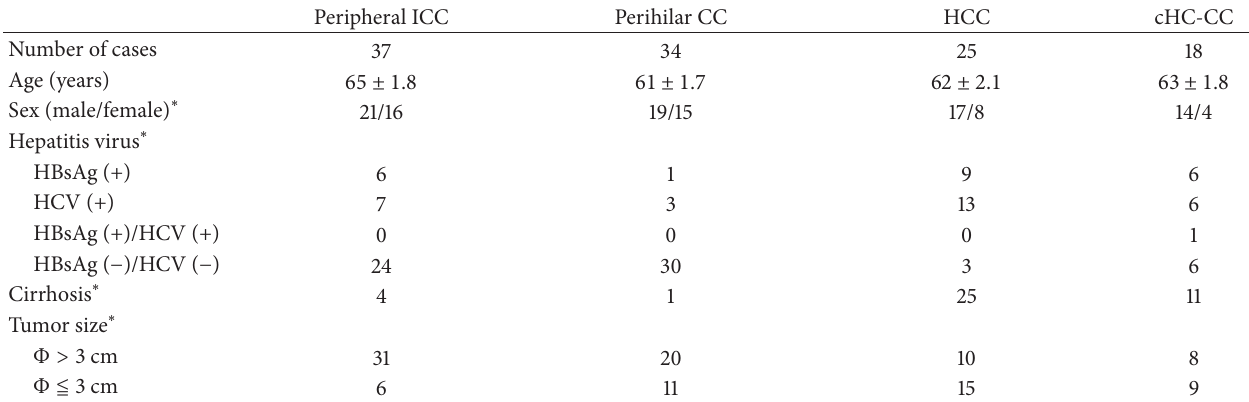
Table 1: Main clinicopathologic features of the cases